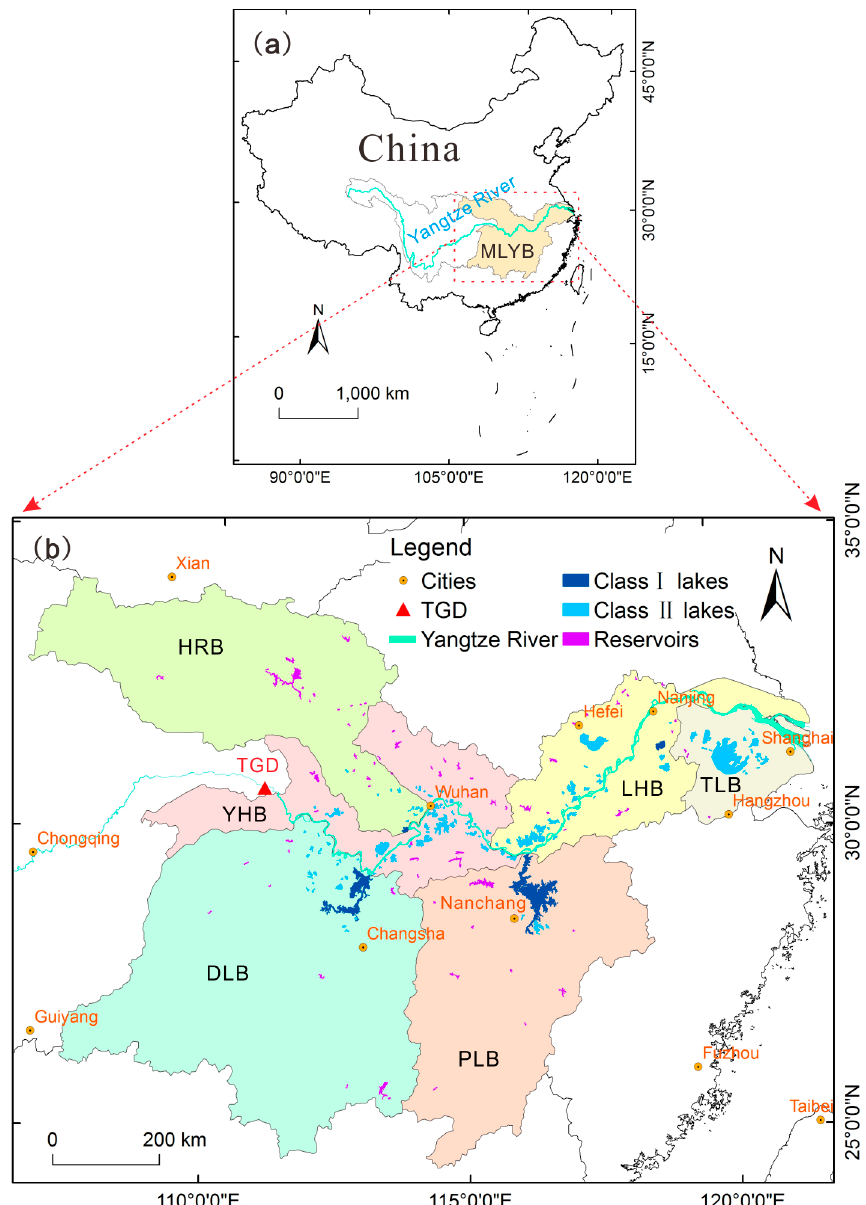
Figure 1. ( a ) The location of the middle and lower Yangtze River Basin (MLYB) in China. ( b ) The distribution of lakes and reservoirs and their sub-basins in the MLYB (HRB: Han River Basin, YHB: Yichang to Hukou Basin, DLB: Dongting Lake Basin, PLB: Poyang Lake Basin, LHB: Lower Hukou Basin, TLB: Tai Lake Basin).